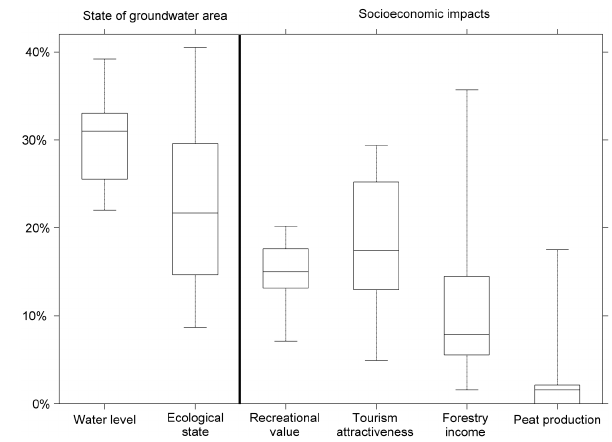
Fig. 5. Importance weights of the criteria in the Rokua Figure 5. Importance weights of the criteria in the Rokua groundwater case given by the interviewed stakeholders (min, median, 75th percentile, max).